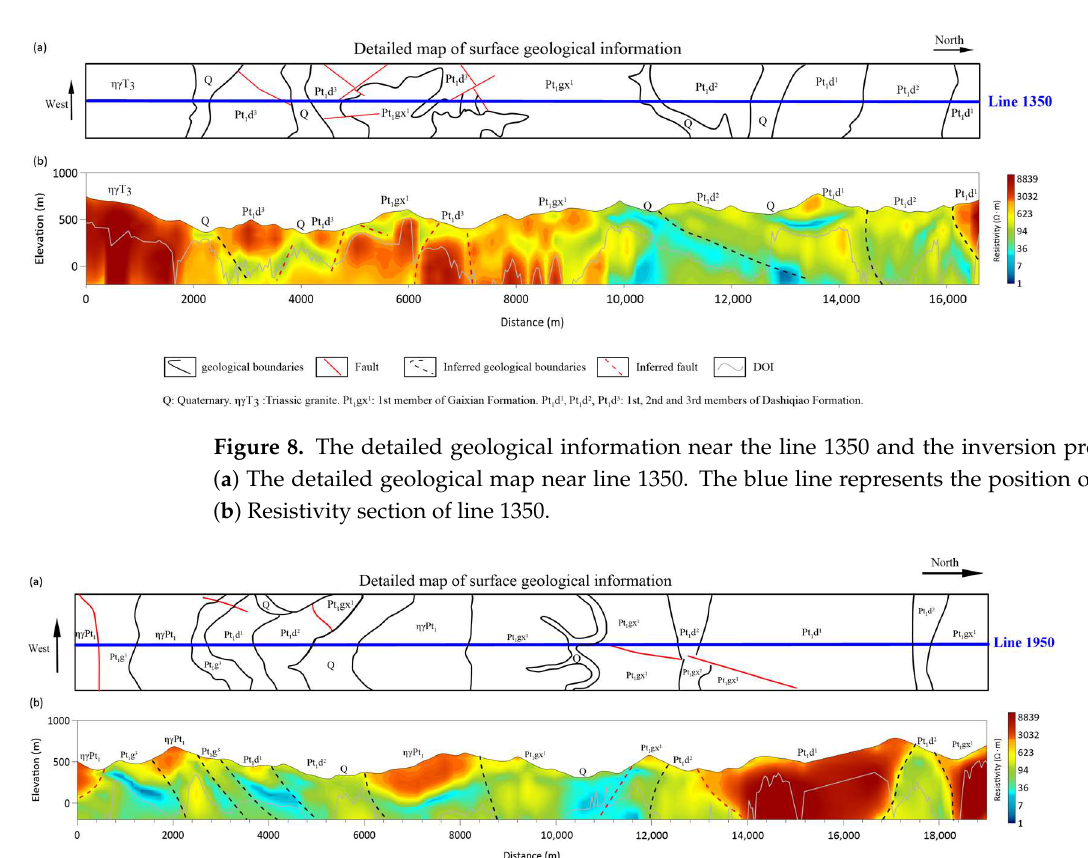
Figure 8. The detailed geological information near the line 1350 and the inversion profile result. ( a ) The detailed geological map near line 1350. The blue line represents the position of line 1350. ( b ) Resistivity section of line 1350.